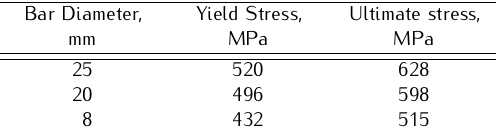
Table 1. Properties of